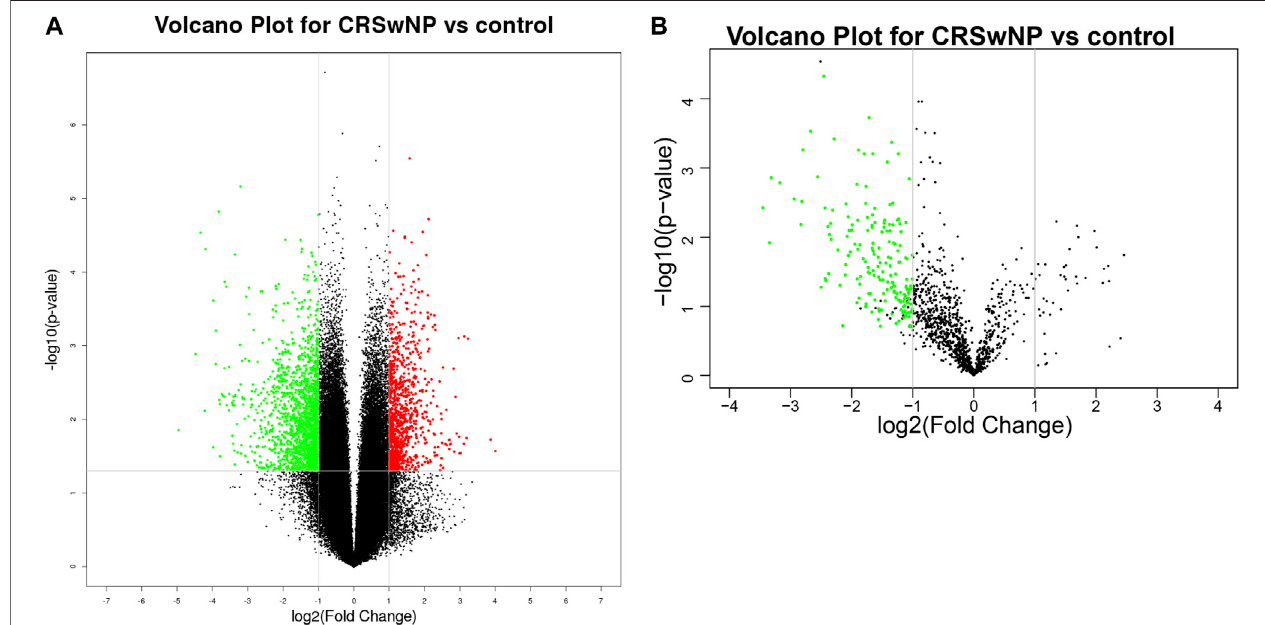
FIGURE 2 | Different expressions of circRNAs and miRNAs shown in volcano plots. The circRNAs and miRNAs were widely distributed in all chromosomes. Each column corresponds to a circRNA or a miRNA, the green column toward the center represents signi fi cantly downregulated and the red one toward the outside means upregulated. (A) Differential expression of circRNAs. (B) Differential expression of